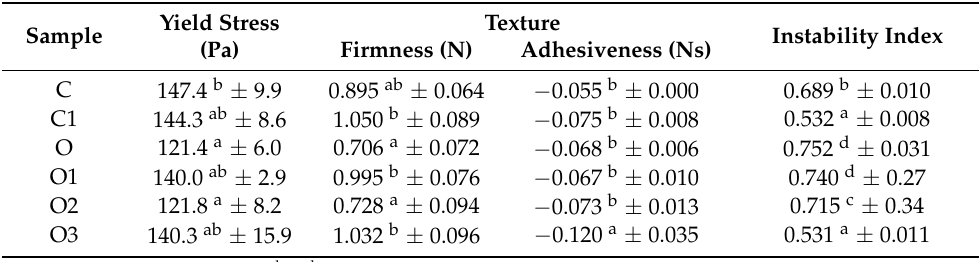
Instability Index